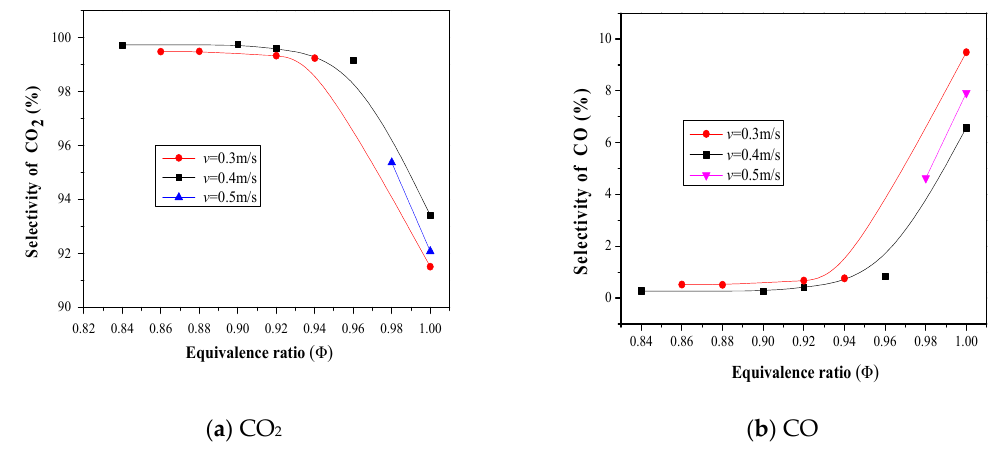
Figure 10. Product selectivity of CO 2 and CO: ( a ) CO 2 ; ( b ) CO.